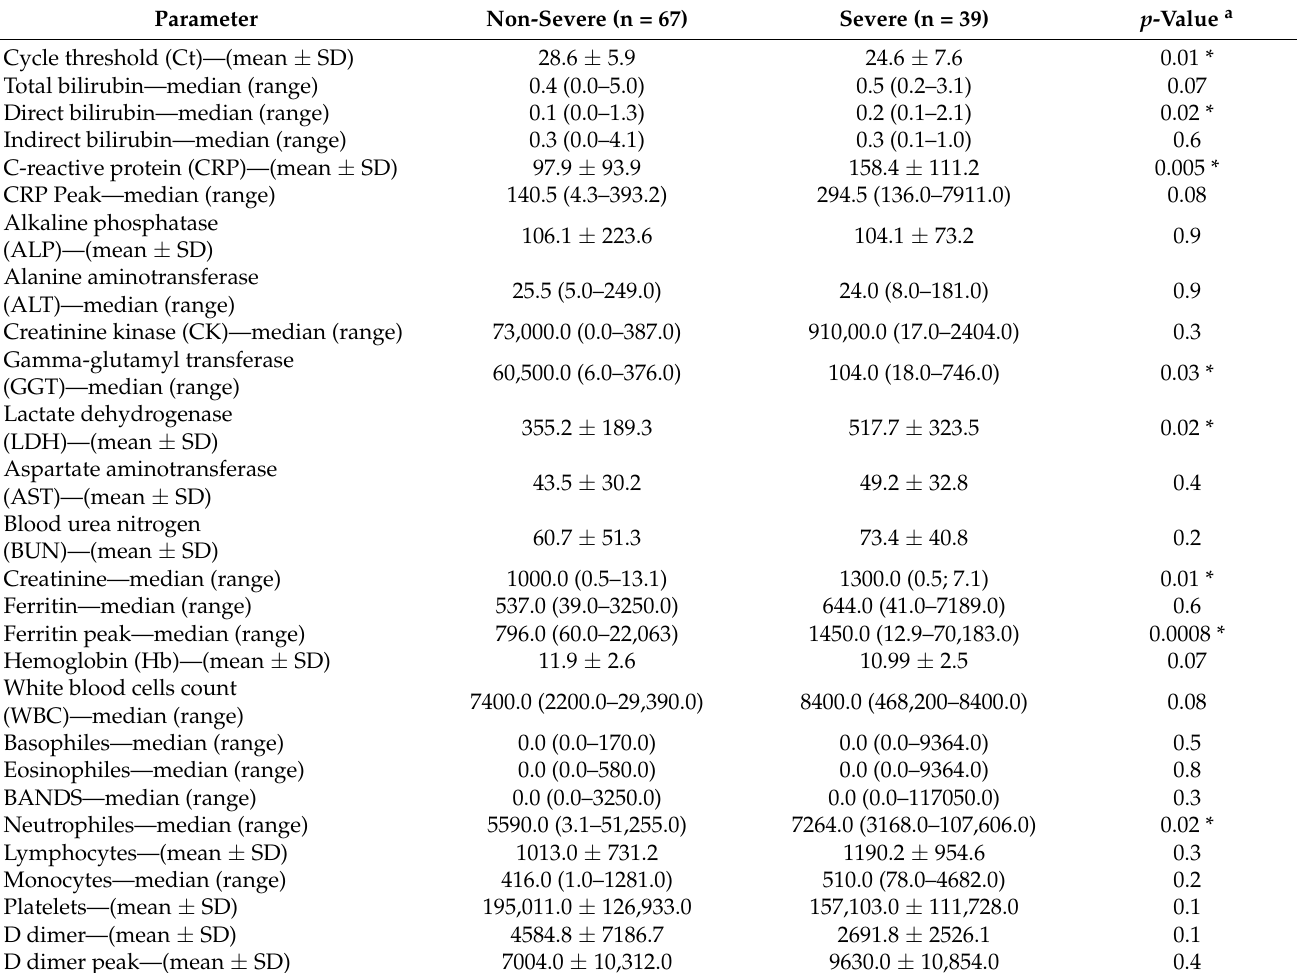
Table 3. Laboratory parameters of COVID-19 patients according to disease severity.